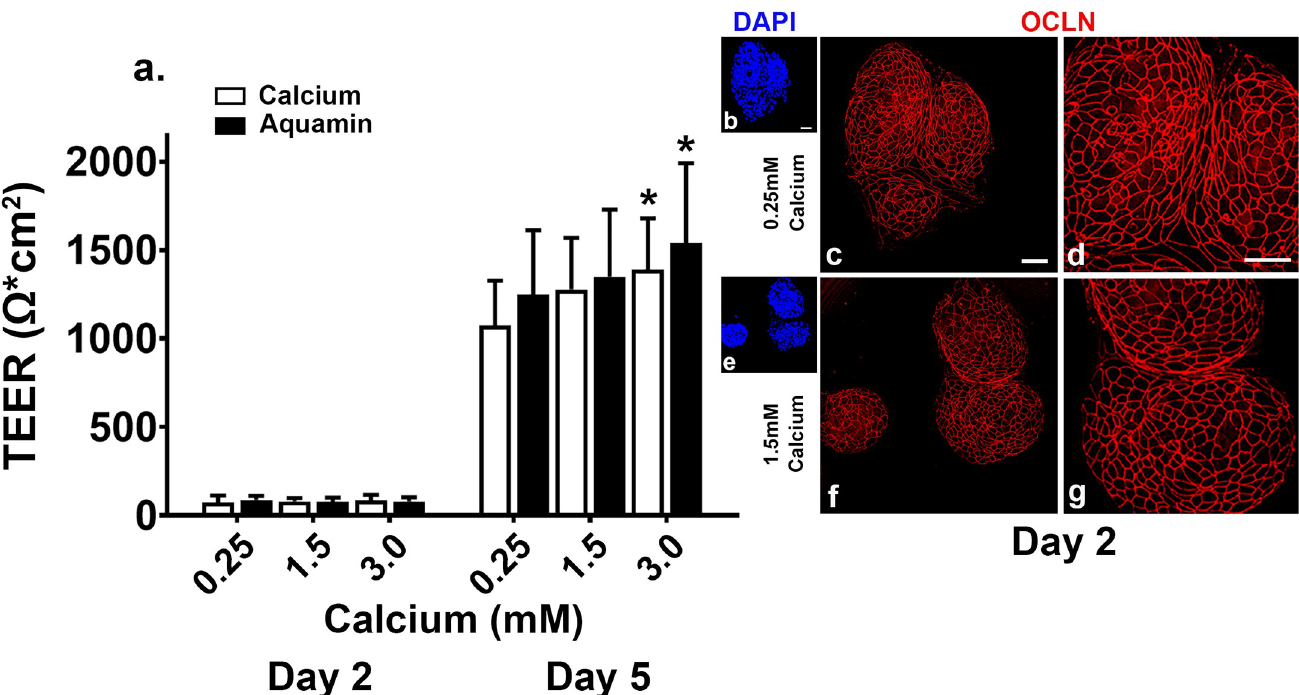
Fig 1. Trans-epithelial electrical resistance (TEER) values. Colonoids were plated on transwell membranes and incubated under the indicated conditions. a : At day-2 and -5, electrical resistance across the cell layer was assessed. Values shown are means and standard deviations based on five separate experiments with 3 or 4 samples (individual membranes) per data point in each experiment). Membrane to membrane variability was routinely less than 5%. Data were analyzed for statistical differences using ANOVA followed by unpaired-group comparisons. � indicate statistical significance from calcium at 0.25 mM ( p < 0.05; calculated by two-tailed unpaired t-test). Inset : Confocal fluorescent microscopic (max projected) images of membranes stained after the day-2 reading with DAPI (panels: b,e ) or with antibody to occludin (panels: c,d,f,g ). Scale bar = 10 μ m. OCLN = occludin.